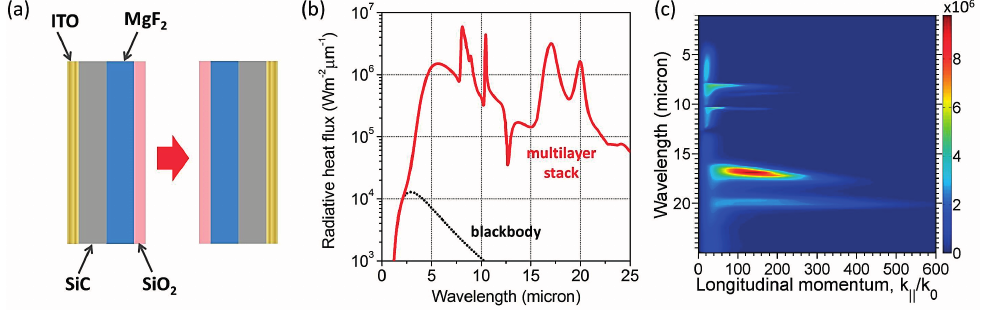
Figure 7. ( a ) Schematic of a multi-layer stack composed of 5 nm SiO 2 film, 5 nm MgF